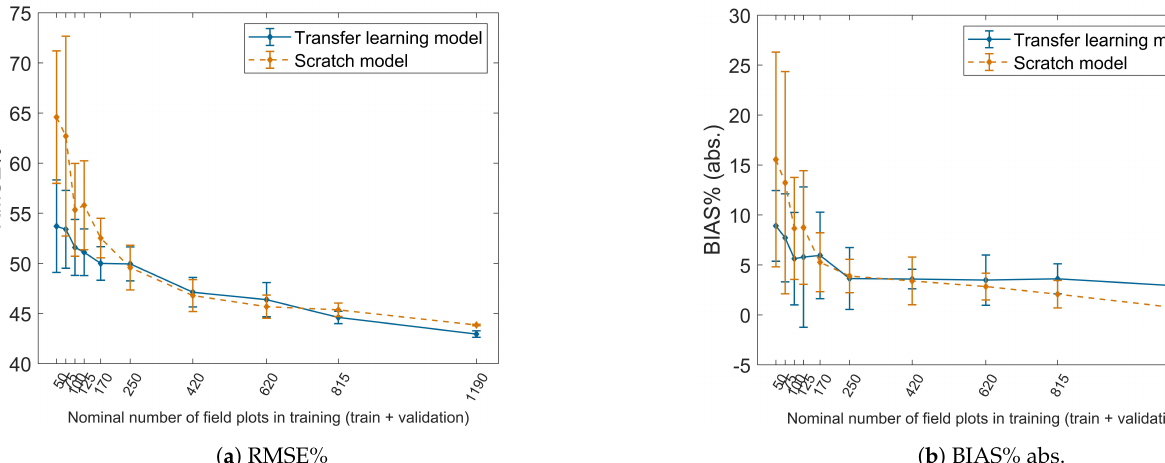
Figure 9. Test set relative root-mean-squared error (RMSE%) and average of relative bias absolute values (BIAS% abs.) for the transfer learning model and for the model trained from scratch for different nominal numbers of field plots. The whiskers show the standard deviation (1 σ ) of the error from the 10 iterations of the same nominal number of field